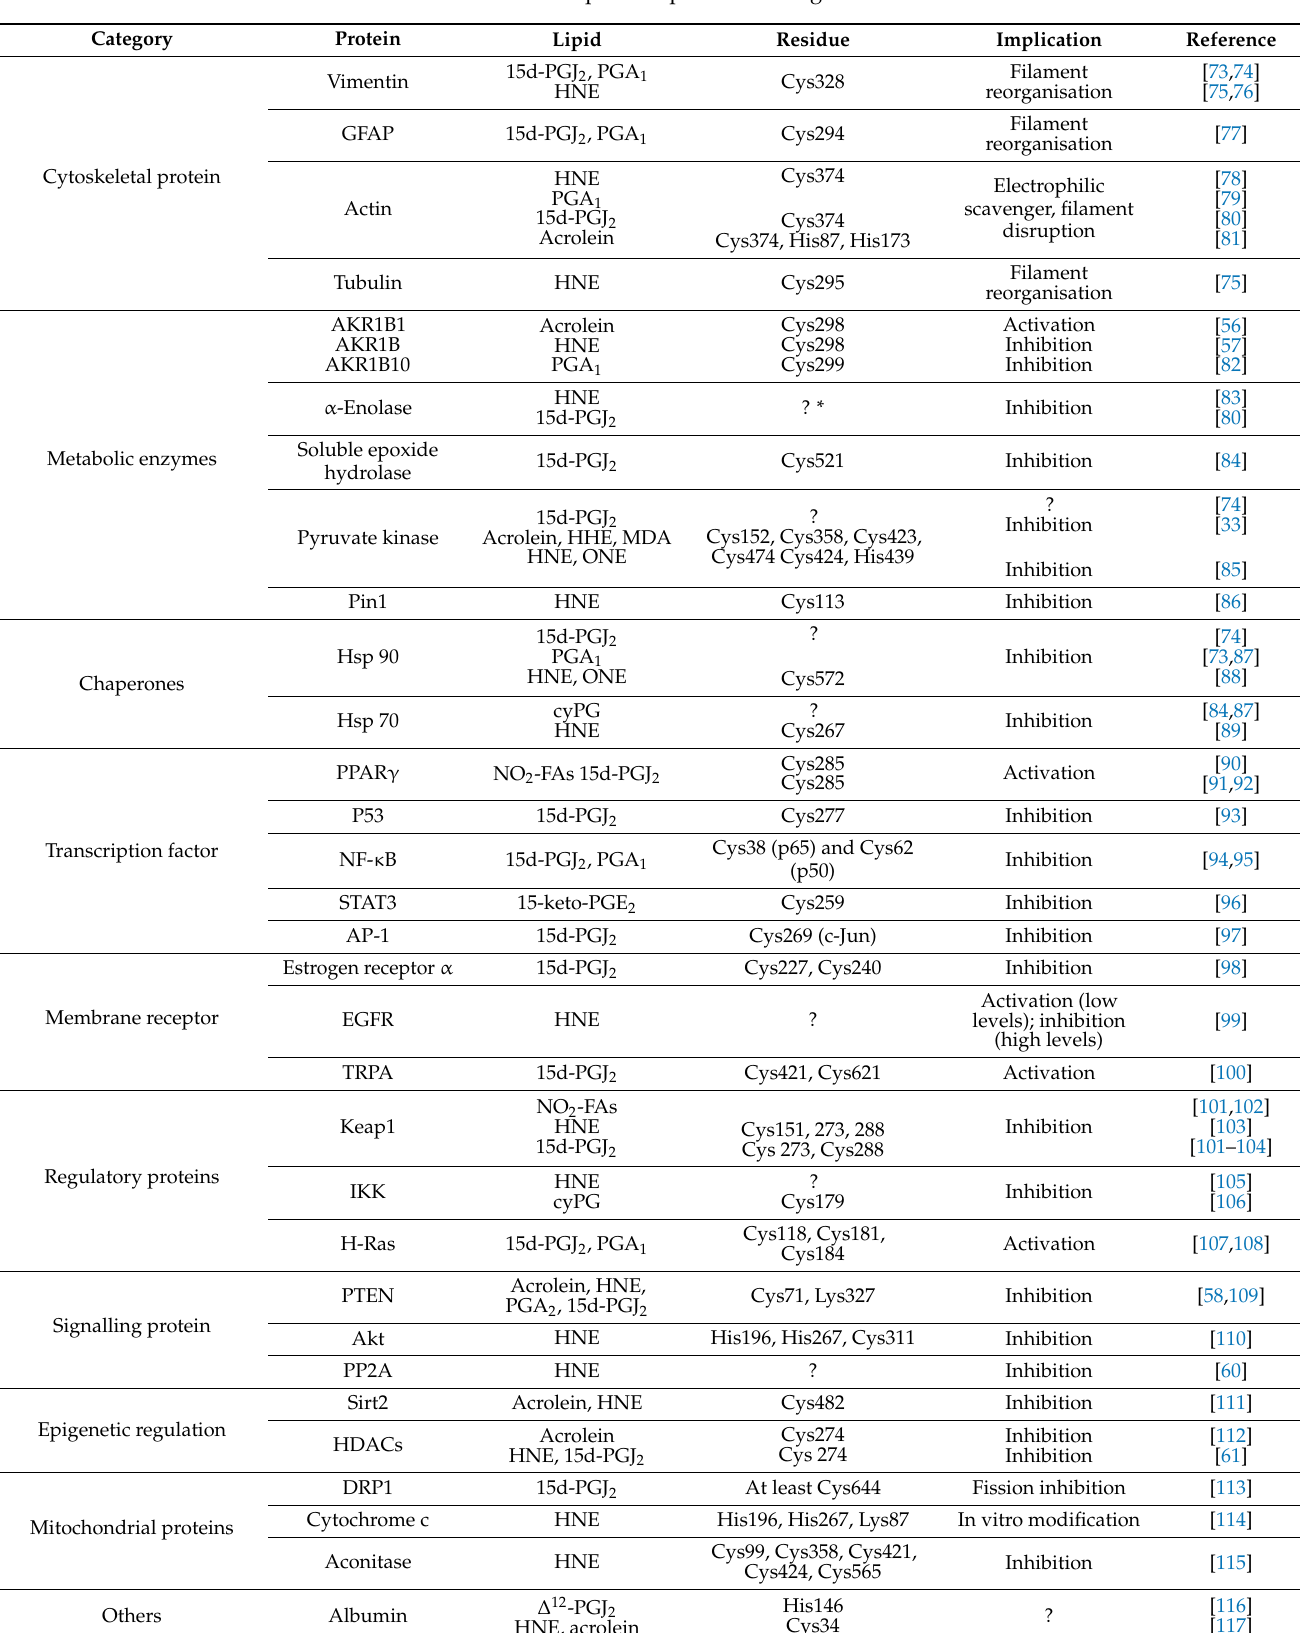
Table 2. Examples of lipoxidation